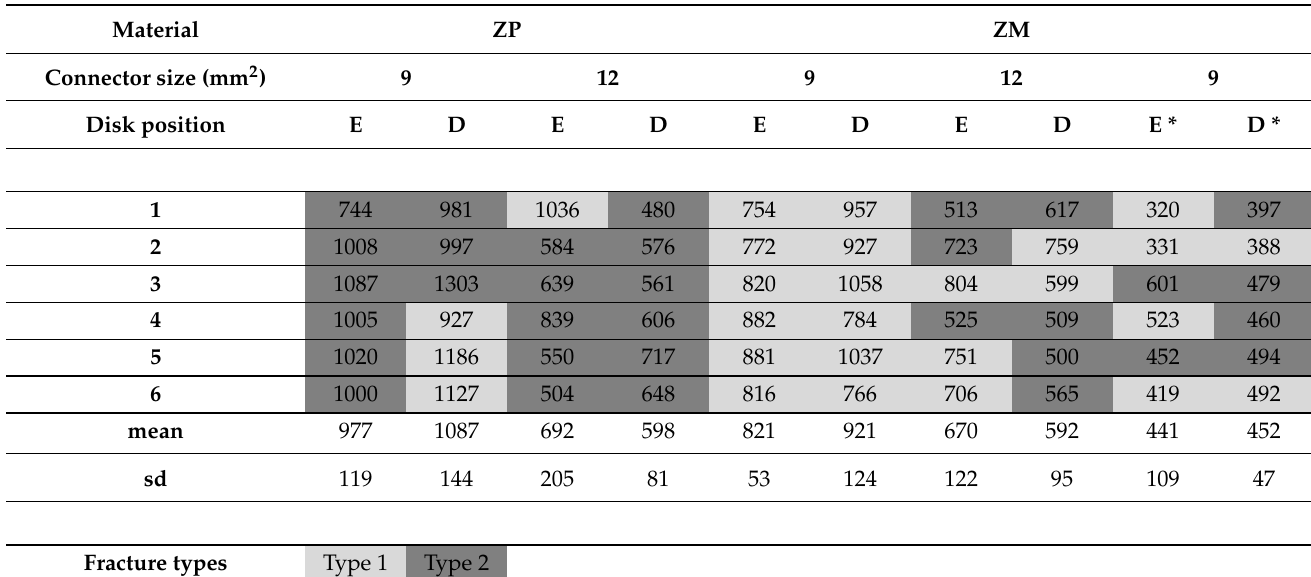
Table 1. Fracture load values of each specimen and mean and standard deviations after chewing simulation. Fracture occurring to each specimen are marked with Type 1 (FDP, light grey) or Type 2 (implant, dark